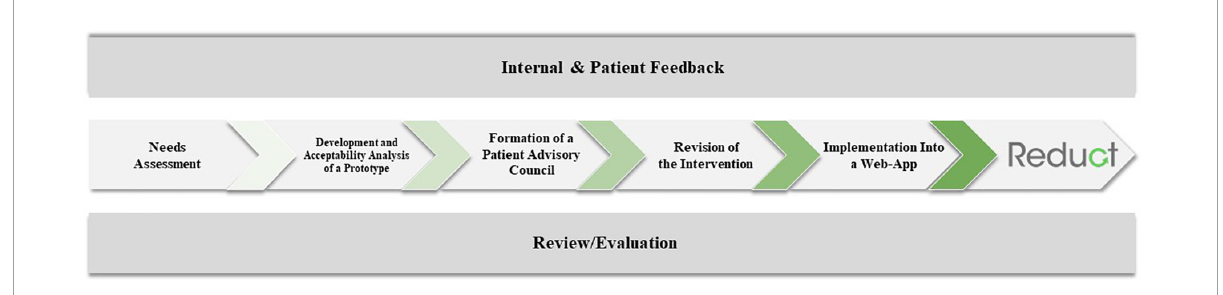
FIGURE1 The development process of the make it training. Note . Reduct Refers to the ongoing evaluation of the Make It Training. Please consult the published study protocol for further information